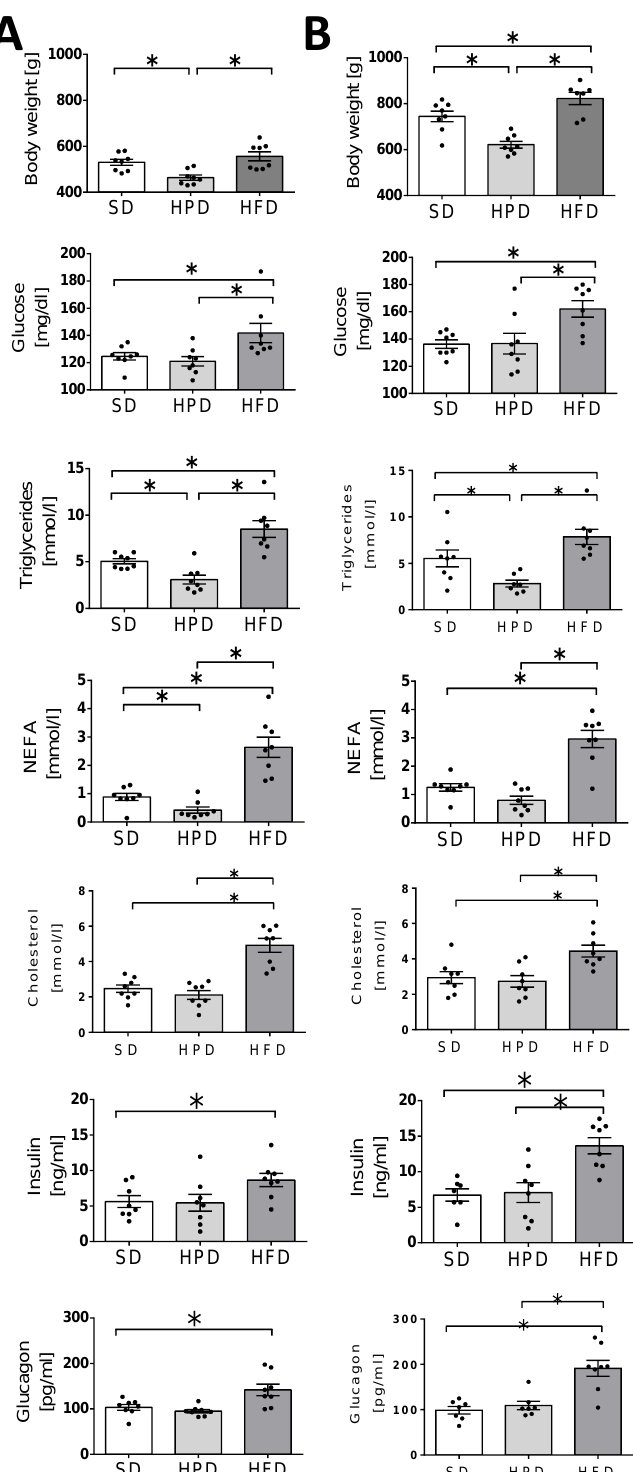
Figure 1. The effects of high-fat diet (HFD) and high-protein diet (HPD) treatment on body weight, glucose, triglycerides, NEFA, cholesterol, insulin, and glucagon concentrations in serum blood after 60 days (panel A ) and 120 days of treatment (panel B ). Results are means ± SEM for n = 8; significant differences between means for control and experimental groups are marked for p < 0.05 (*).